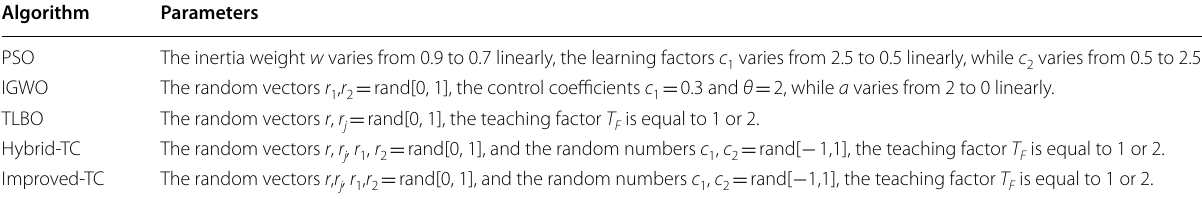
Table 3 The settings of algorithm parameters QoS aggregation